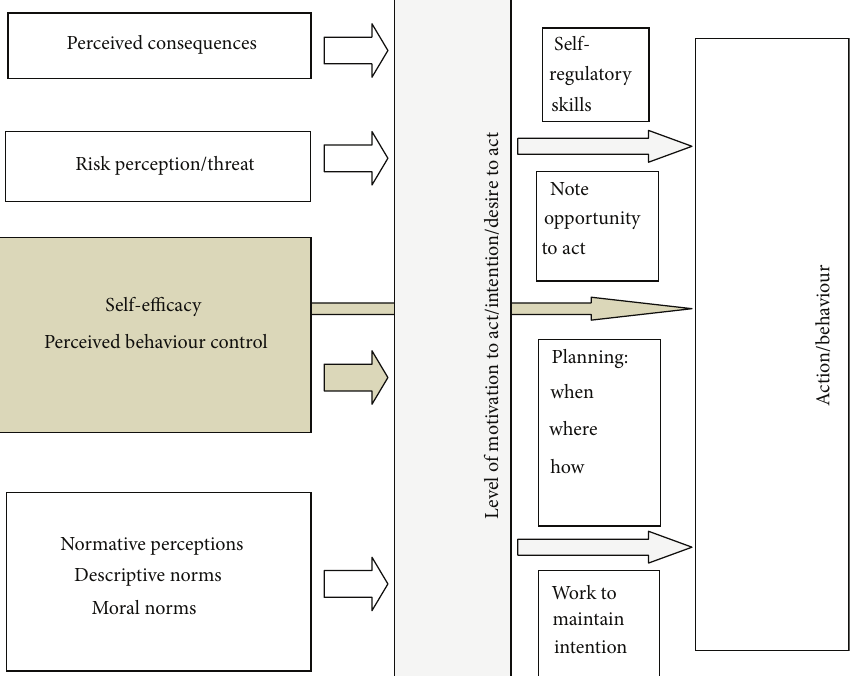
Figure 1: Social Cognitive concepts appearing in many individualistic behaviour change